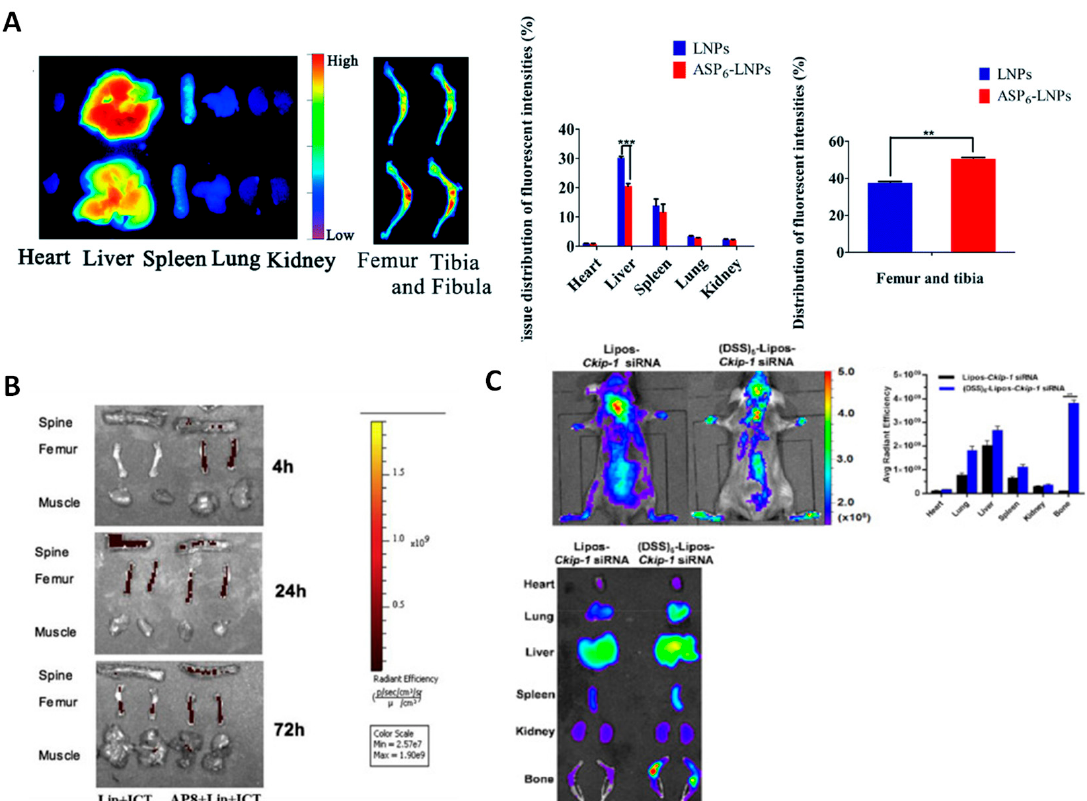
Figure 5. Representative images displaying the biodistribution and bone accumulation of NPs func- tionalized with different bone-targeting agents compared to their non-targeted counterparts. ( A ) functionalized with different bone-targeting agents compared to their non-targeted (Asp) 6 , ** p < 0.01, *** p < 0.001. ( B ) (Asp) 8 . ( C ) (AspSerSer) 6 . Adapted with permission from [46] (The Royal Society of Chemistry), [87] (Elsevier), and [88] (Elsevier).